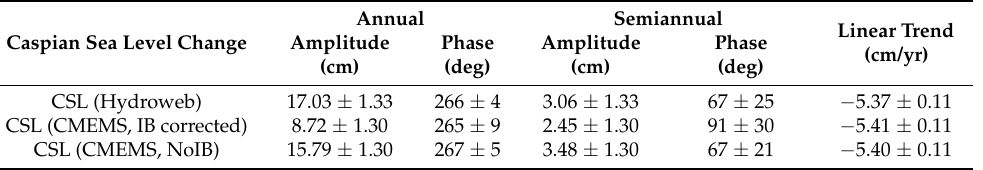
Figure 3. Nonseasonal Caspian Sea level changes (in units of cm) observed by satellite altimeter over the period of January 1993 to December 2021, provided by the Hydroweb project (https://hydroweb.theia-land.fr/; Accessed on October 24 2022) and CMEMS global sea level anomaly product (https://data.marine.copernicus.eu/; Accessed on July 27 2022). The two lines (red and blue) represent the linear trends estimated from least-squares fit (the two lines are mostly overlapped with each other, as the estimated trends are too close). The estimated trends, −5.36 cm/yr, and −5.41 cm/yr are labeled in the plot with corresponding colors. Table 1. Annual and semiannual amplitudes and phases and trends of the Hydroweb and CMEMS CSL altimetry series for January 1993 to December 2021 estimated from unweighted least-squares fit.